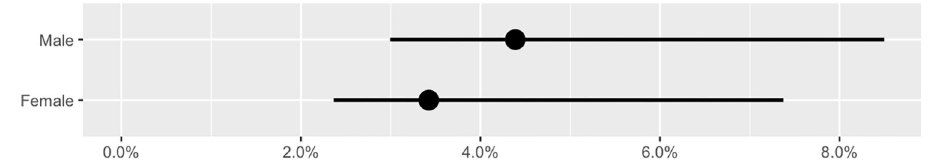
Fig 3. Estimated anti-SARS-CoV-2 seroprevalence across sex in King County in early-to-mid-August 2020. Points indicate estimates and lines indicate 95% confidence intervals.